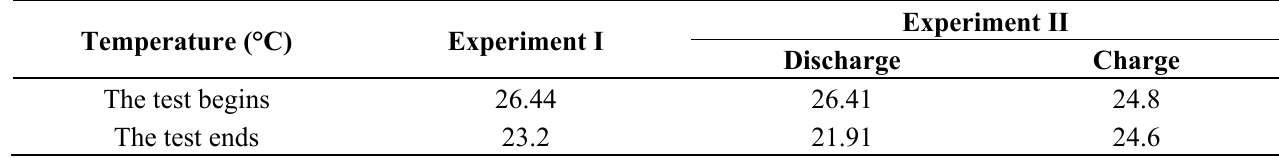
Table 2. The average temperature of the two experiments.